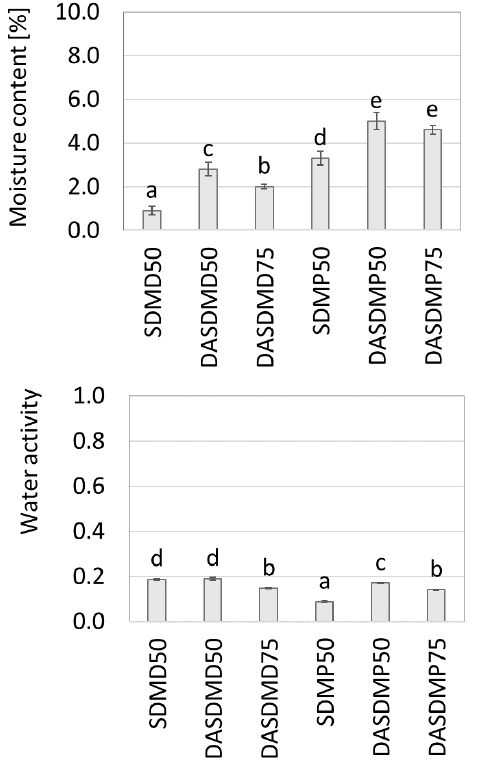
Figure 4. Moisture content (MC) and water activity ( a w ) of buckwheat honey powders containing 50 and 75% honey solids obtained with maltodextrin (MD) or milk powder (MP) as carriers by conventional spray drying (SD) and dehumidified-air-assisted spray drying (DASD).